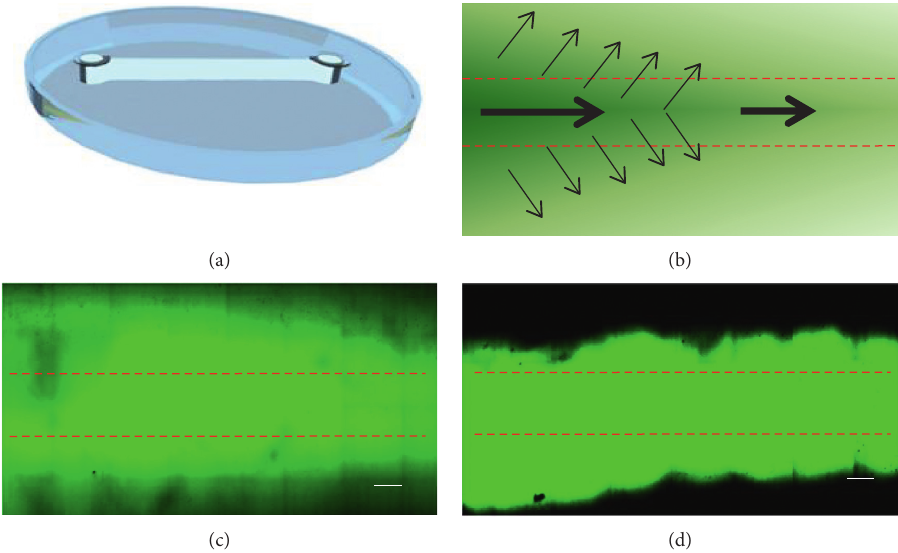
Figure 3: Transport of small molecule and macromolecule in the microfluidic network. (a) 3D schematic diagram of the microfluidic network. (b) The exchange of solutes within a bulk gel is generally conducted in two steps: convective mass transfer between the fluid and the walls of the microchannels and molecular diffusion between the walls and the bulk of the matrix. (c, d) Fluorescence distribution within the bulk matrix after injecting fluorescein and FITC-BSA solution into the channel for 10min, respectively. The red dotted line indicates the channel within the bulk matrix (bar: 200 μ